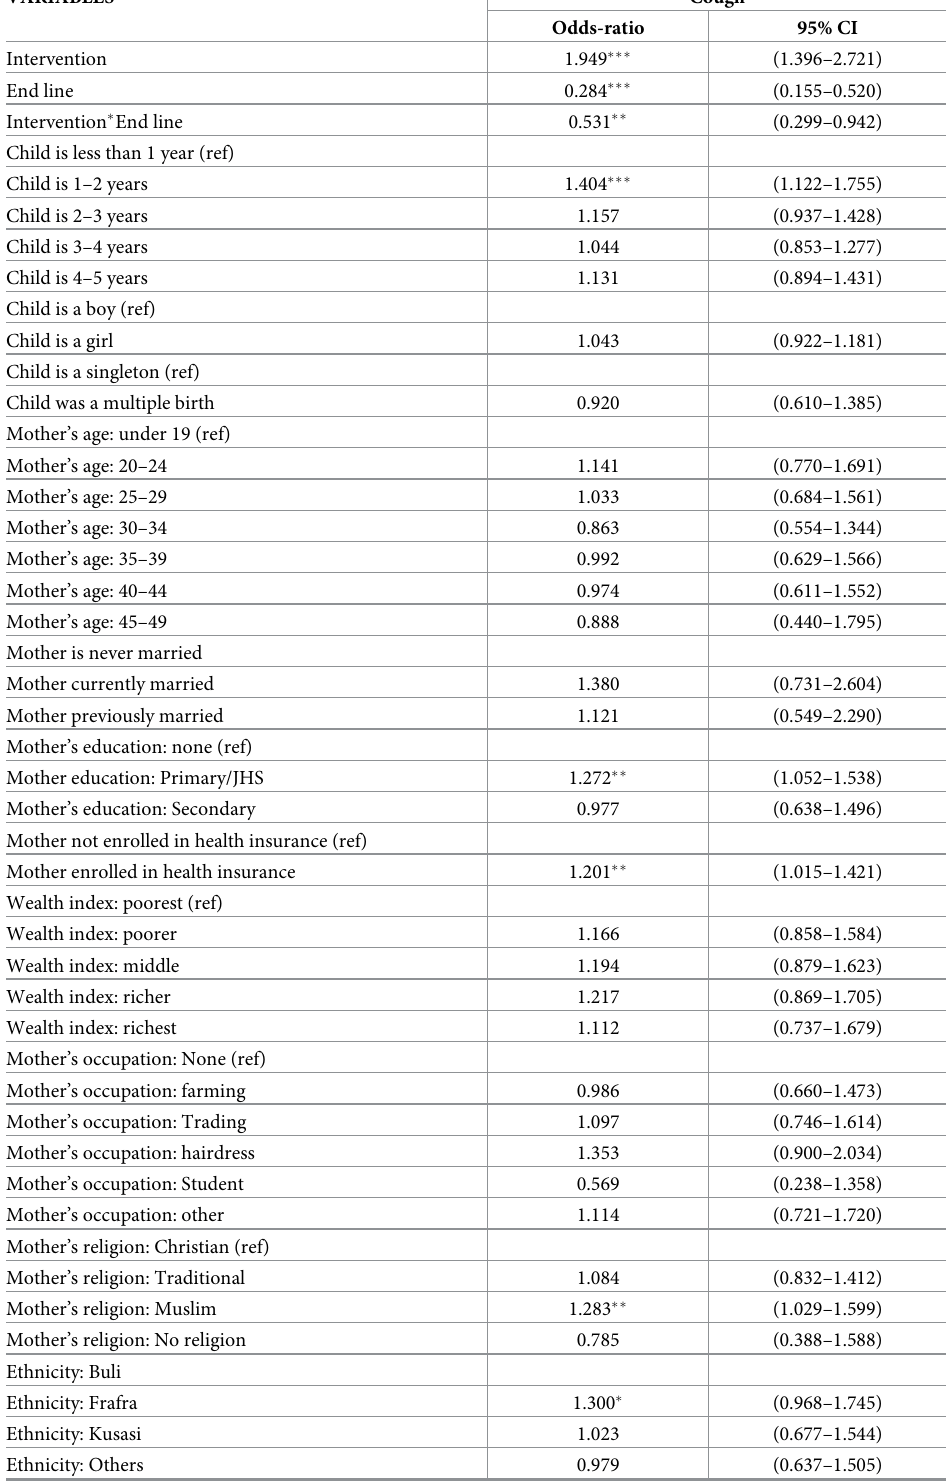
Table 4. The estimated effect of GEHIP on health system childhood morbidity